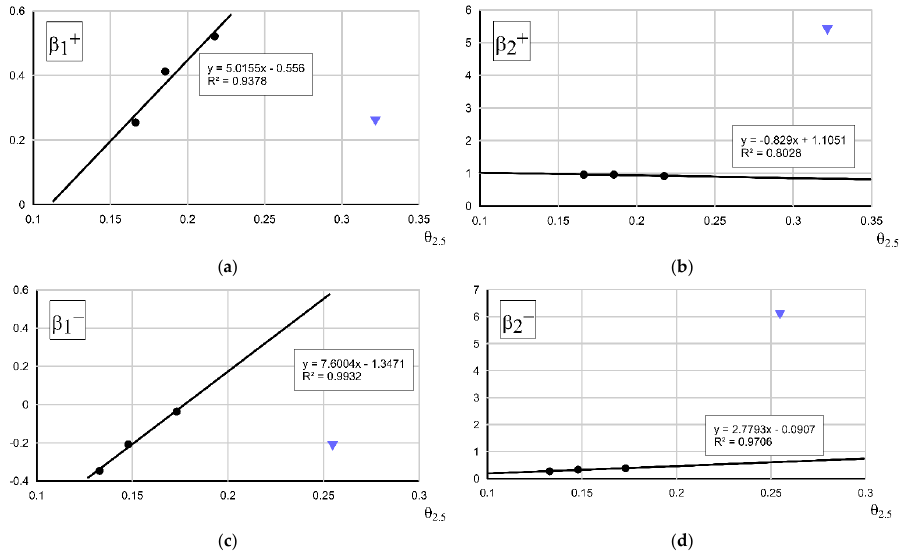
Figure 6. Plots of sediment flux correction factors over a sloping seabed: ( a ) fine fractions, crest phase; ( b ) coarse fractions, crest phase; ( c ) fine fractions, trough phase; ( d ) coarse fractions, trough phase.